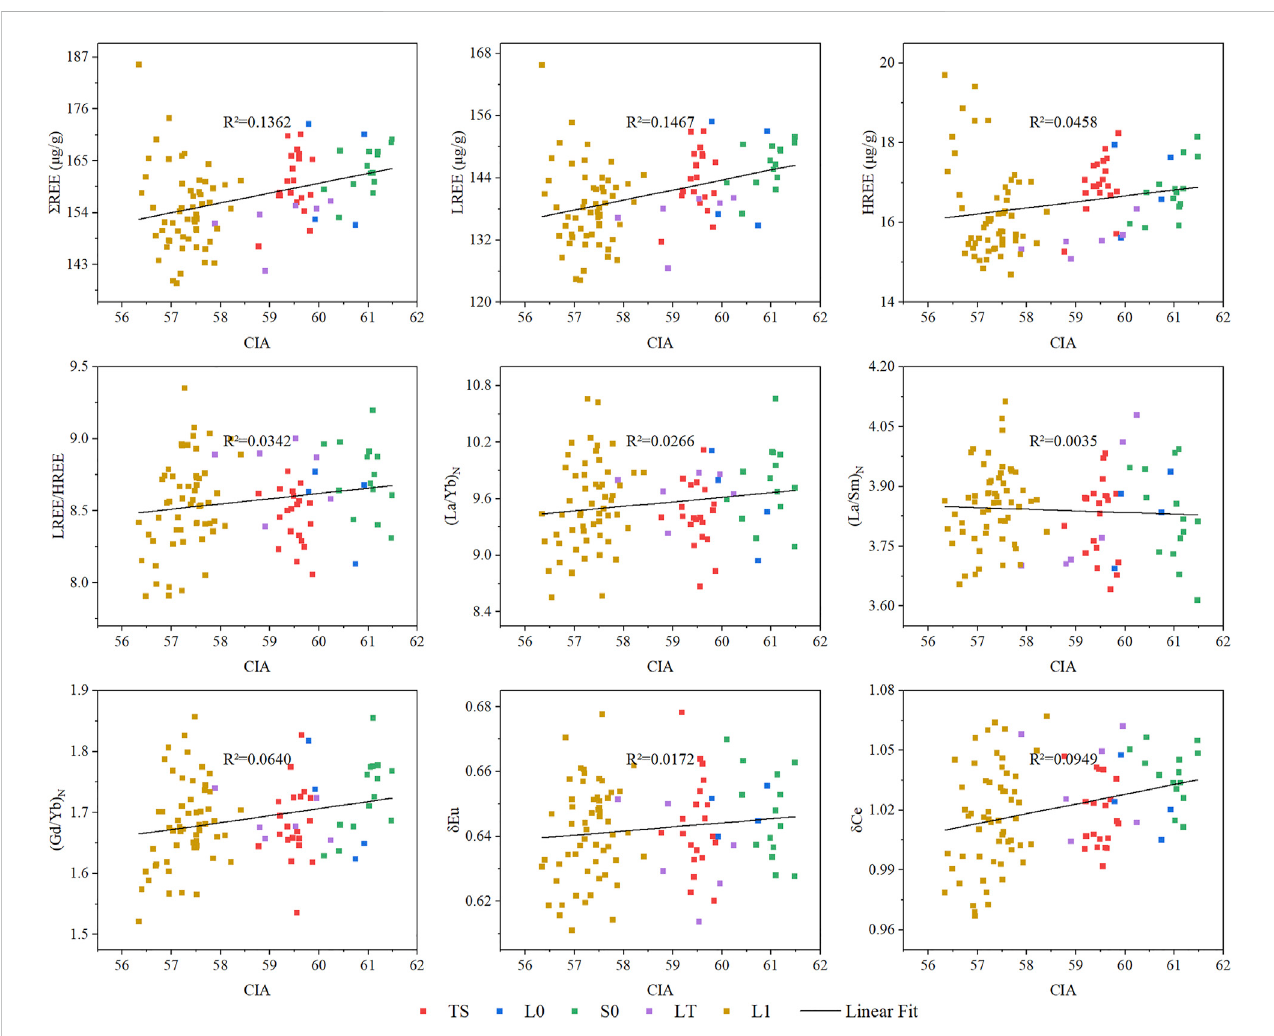
The relationships between CIA versus diverse parameters of rare earth elements in Menyuan